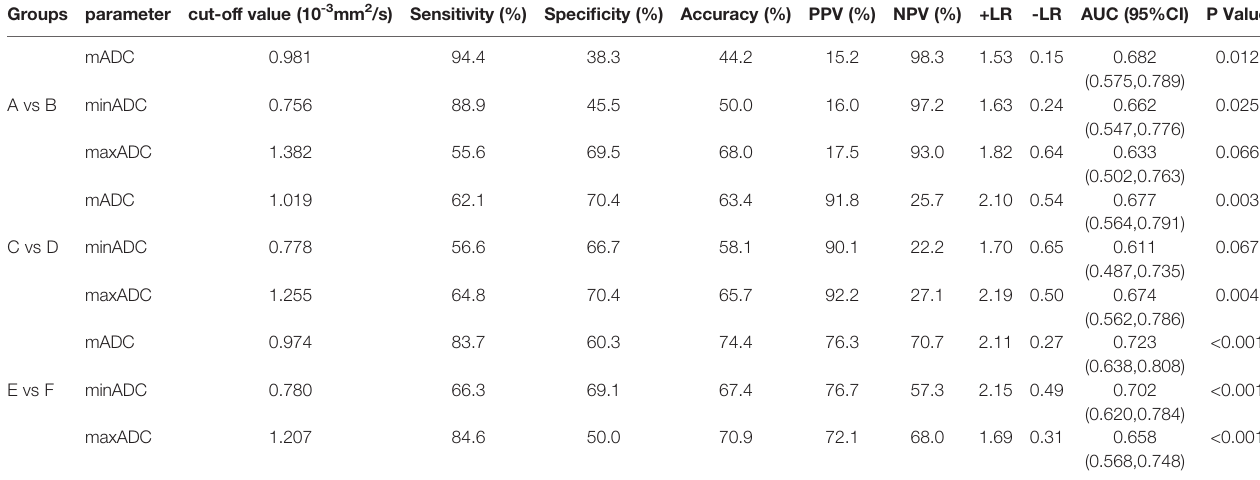
TABLE 3 | Diagnostic performance of different groups assessed by mADC, minADC and maxADC.